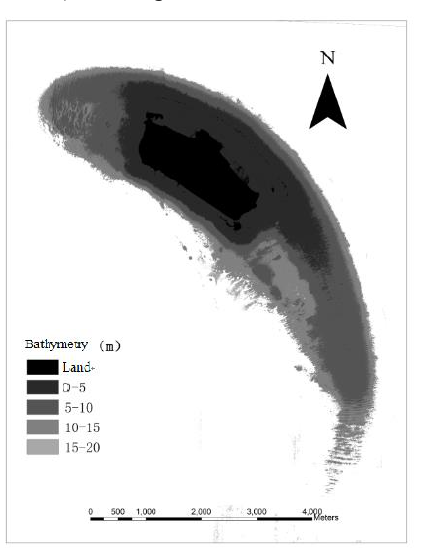
Figure7 Bathymetry estimated from semi-analytical inversion model over East Island